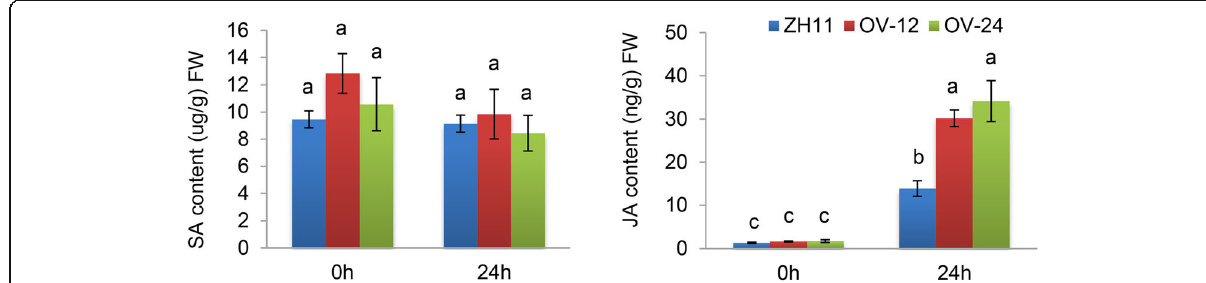
Fig. 6 Increased accumulation of jasmonic acid in OsPGIP1 -overexpressing compared with ZH11 after inoculation with Xoc . The SA and JA contents were measured in the ZH11 and OsPGIP1 -overexpressing lines OV-12 and OV-24 without inoculation and 24 h postinoculation with RS105. The letters above the bars represent the significant differences at a value of P ≤ 0.05 (LSD